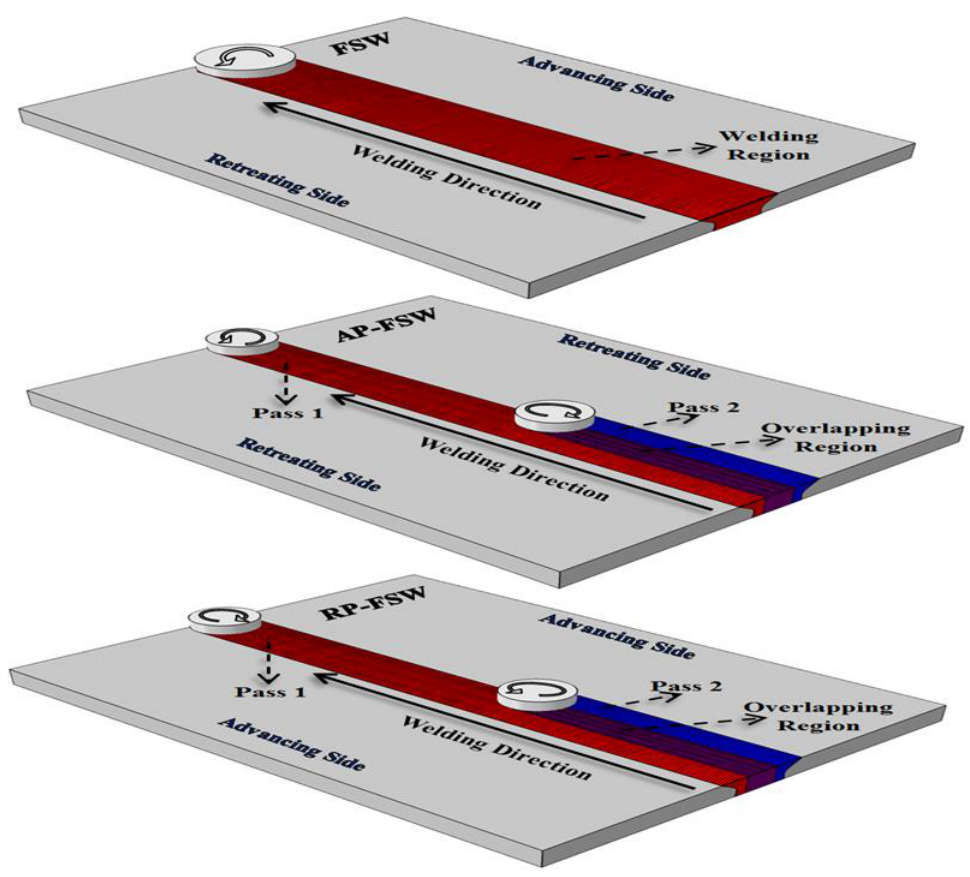
Figure 1. The schematic of the FSW, RP-FSW, and AP-FSW processes.